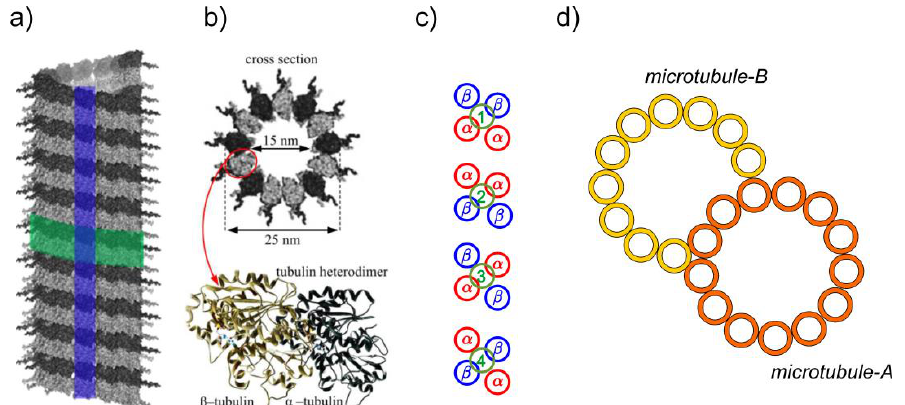
Figure 2. ( a ) MT cylinder of 13 parallel protofilaments (one protofilament is depicted in blue, helical symmetry in green; ( b ) the cross section of a MT with denoted dimensions, and tublin α - β hetero- dimer (secondary structure); ( c ) four types of nanopores in MT wall; ( d ) the microtubule doublet consists of A-MT and B-MT, with 13 and 10 protofilaments, respectively